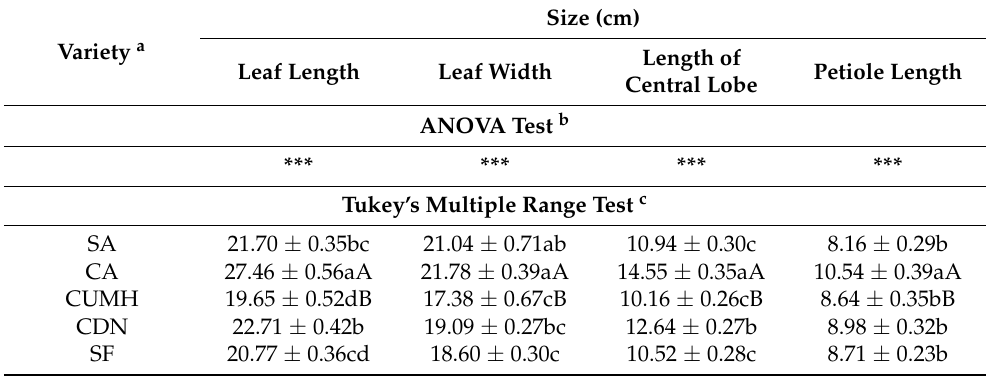
Table 1. Mean values of morphological characteristics of leaves of different varieties of Ficus carica . Size (cm) Variety a Length of Petiole Length Leaf Length Leaf Width Central Lobe ANOVA Test b *** *** *** *** Tukey’s Multiple Range Test